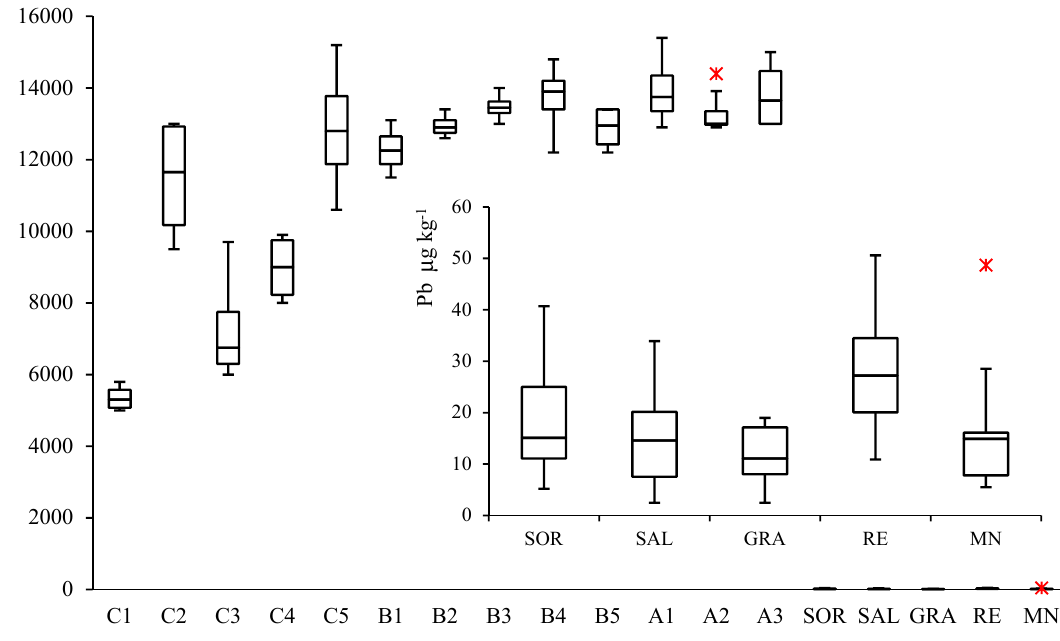
0200040006000800010000120001400016000 Figure 2. Box and whiskers plot representation of the lead concentrations data for soil, C1—C5, B1–B5, A1—A3 and wine samples, Lambrusco Sorbara, SOR; Lambrusco Salamio, SAL; Lambrusco Grasparossa, GRA; Lambrusco Reggio Emilia, RE; Lambrusco Mantova, MN, respectively.